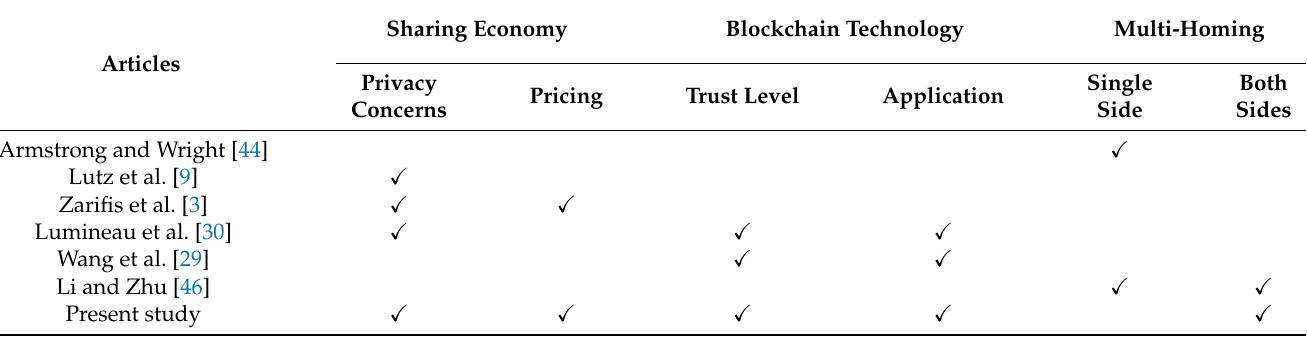
Table 1. Summary of Main